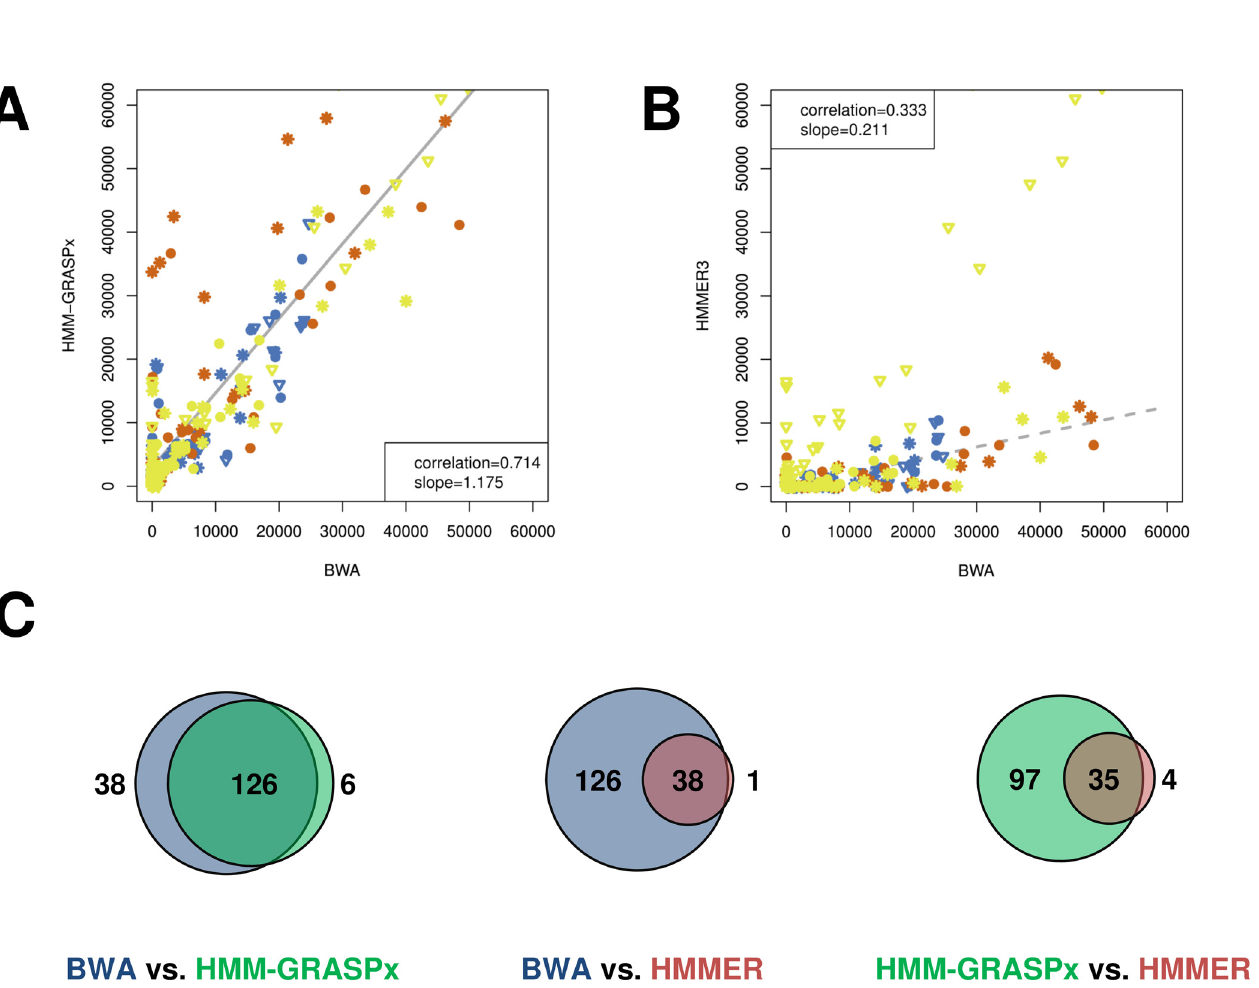
Fig 3. Comparison of HMM-GRASPx- and HMMER3-generated results from the in vitro human oral plaque biofilm MT data set. (A) Abundances correlation between HMM-GRASPx predictions and the ground-truth (i.e. BWA). The x- and y-axis indicate the number of homologous reads recruited by the corresponding programs. Colors indicate different conditions where the libraries were constructed (blue for 0hr/ pH 7.0, red for 6hr/pH 4.2, and yellow for 9hr/pH 5.2). Different marks indicate different replicates. (B) Abundances correlation between HMMER3 predictions and the ground-truth. (C) Venn diagram showing the overlap between detected DE genes using HMM-GRASPx predictions (green), HMMER3 predictions (red), and the ground-truth homologous reads (blue).